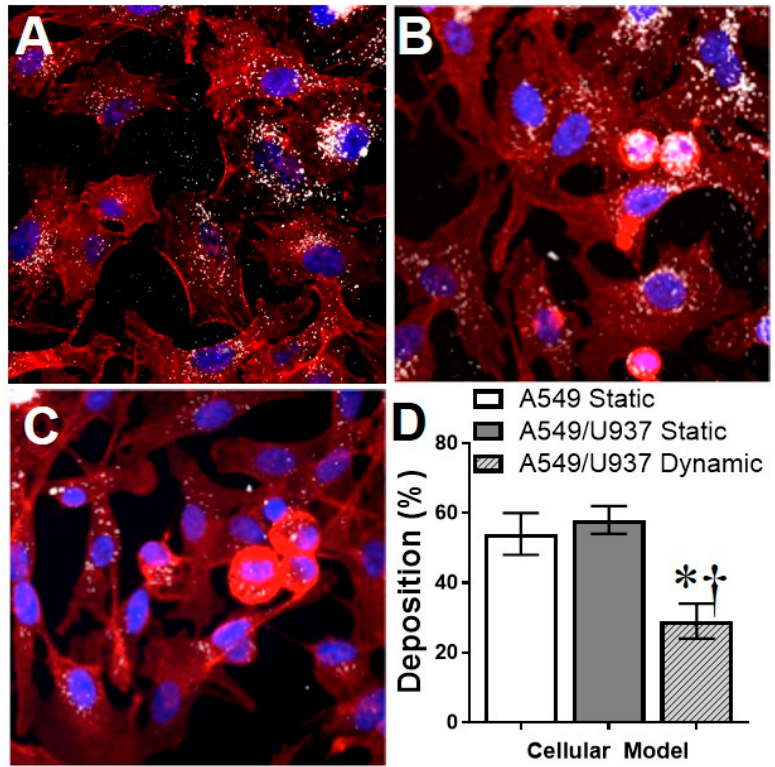
Figure 3. Evaluation of the AgNP-cellular interactions. Following a 24 h exposure to 5 µ g/mL AgNPs the nano-cellular interface was visualized for the ( A ) static A549, ( B ) static A549/U937 co-culture, and ( C ) dynamic A549/U937 co-culture systems. In these images, actin and nuclei are stained red and blue, respectively with AgNPs appearing as white. ( D ) After a 24 h exposure, the AgNP deposition efficiency was measured via ICP-MS for all experimental systems. * and † denote statistical significance from untreated static A549 cells and between A549/U937 static and dynamic at the same AgNP concentration, respectively, n = 3, p < 0.05.